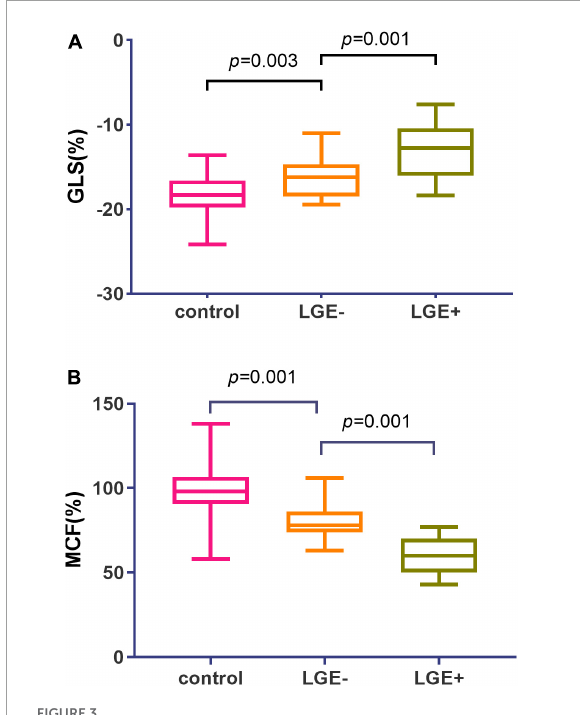
FIGURE3 Global myocardial longitudinal strain (GLS) and myocardial contraction fraction (MCF) values in hypertrophic cardiomyopathy (HCM) subgroups with or without LGE. (A) Patients with LGE + exhibited a stepwise elevation in GLS (–13.1 vs. –16.3 vs. –18.2) as compared to LGE- subgroup and controls. (B) Patients with LGE + exhibited a stepwise reduction in MCF (98.6%vs. 78.5%vs. 59.3%) as compared to LGE- subgroup and